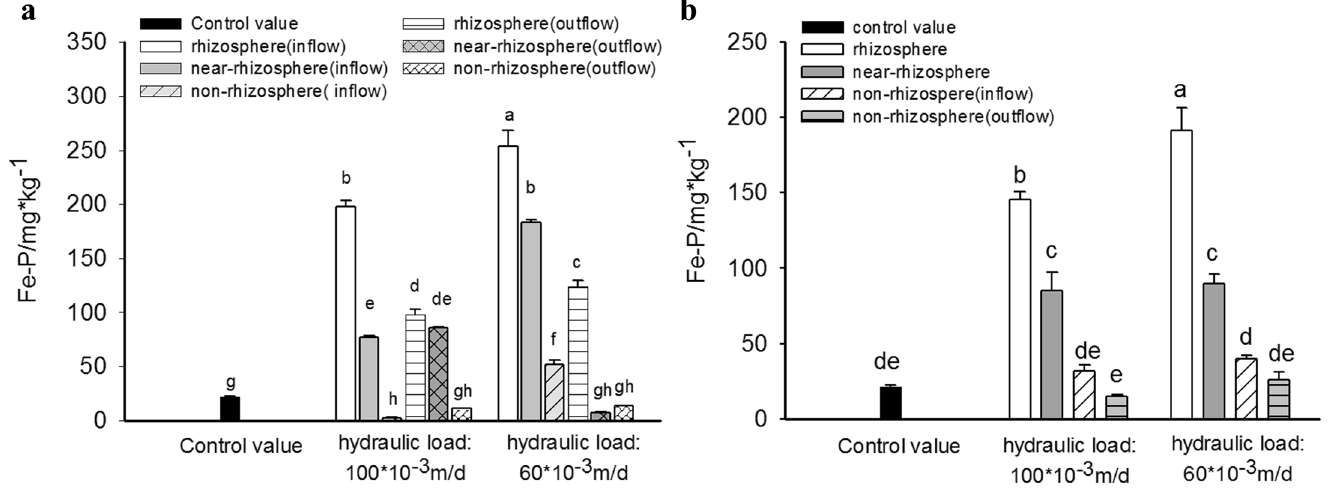
Fig 4. Content of Fe-P in substrates in different zone of HSSF CWS(a) and VSSF CWS(b) with high and low hydraulic loading rate.